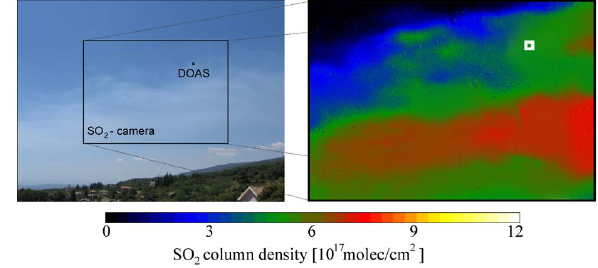
Fig. 13. Visible (left) and SO 2 camera (right) images recorded over Figure 13 – Visible (left) and SO 2 camera (right) images recorded over the town of Milo at 8 the town of Milo at the base of Mt. Etna on 16 July 2008. The the base of Mt. Etna on July 16, 2008. The rectangle in the visible image indicates the section 9 rectangle in the visible image indicates the section observed by the observed by the SO 2 camera. The images were taken in southerly direction, the plume was 10 SO 2 camera. The images were taken in southerly direction, the moving from right to left through the images. The SO 2 image was slightly smoothed to 11 plume was moving from right to left through the images. The SO 2 remove artifacts caused by dust in the optical system. A passive DOAS instrument was also 12 image was slightly smoothed to remove artifacts caused by dust in aimed at the volcanic plume. Its approximate viewing direction is indicated by a small 13 the optical system. A passive DOAS instrument was also aimed at rectangular dot in both images. 14 the volcanic plume. Its approximate viewing direction is indicated by a small rectangular dot in both images.